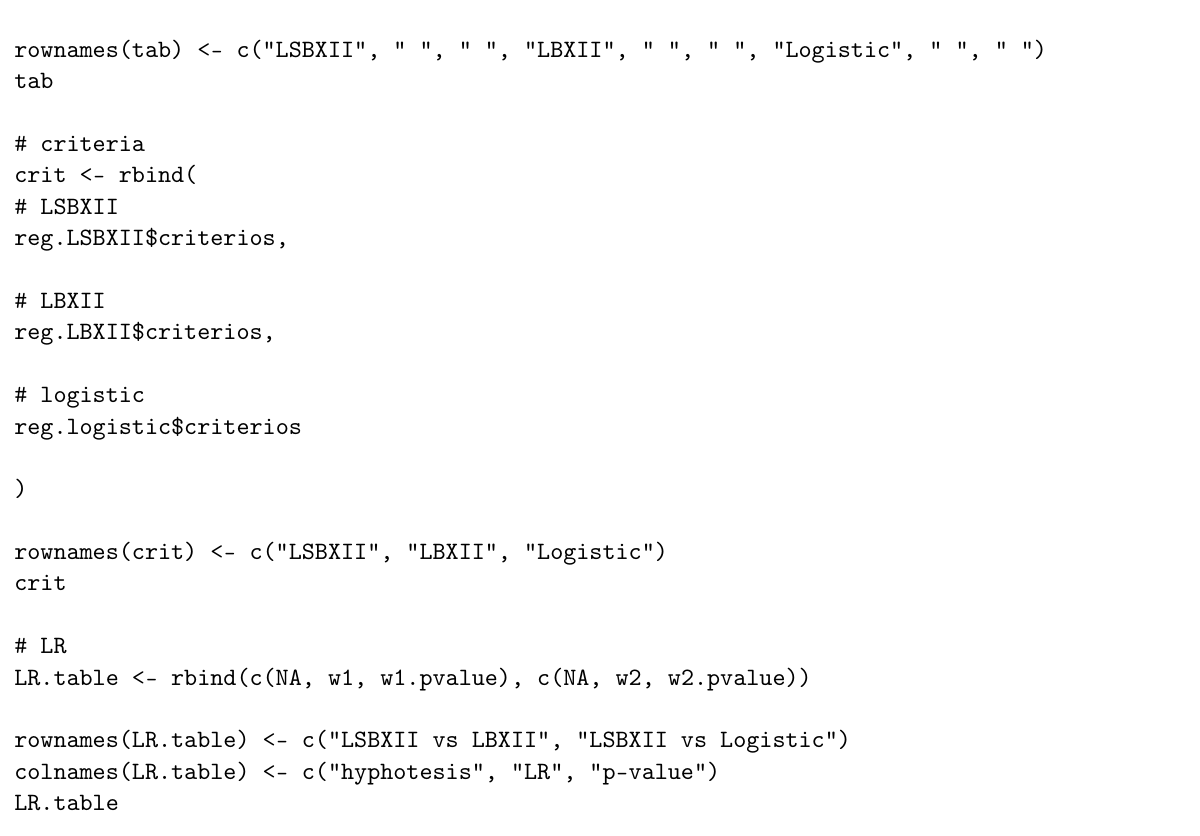
LR.table <- rbind(c(NA, w1, w1.pvalue), c(NA, w2,